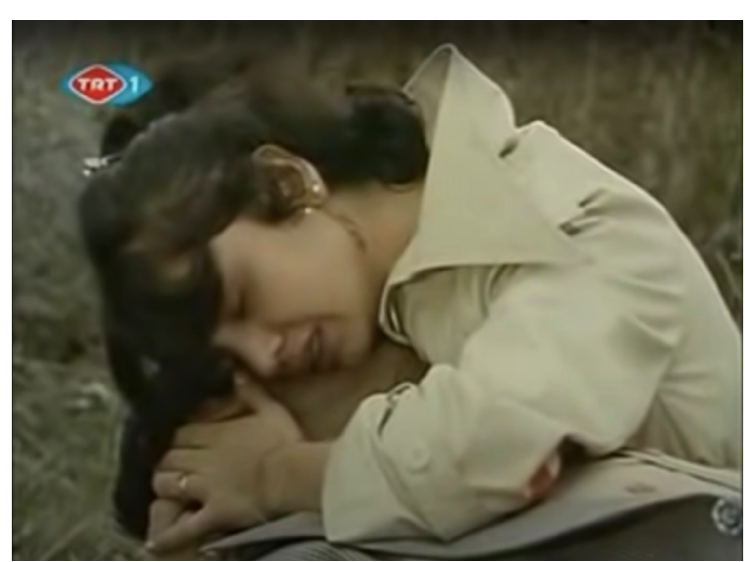
Figure 5: Orhan’s death